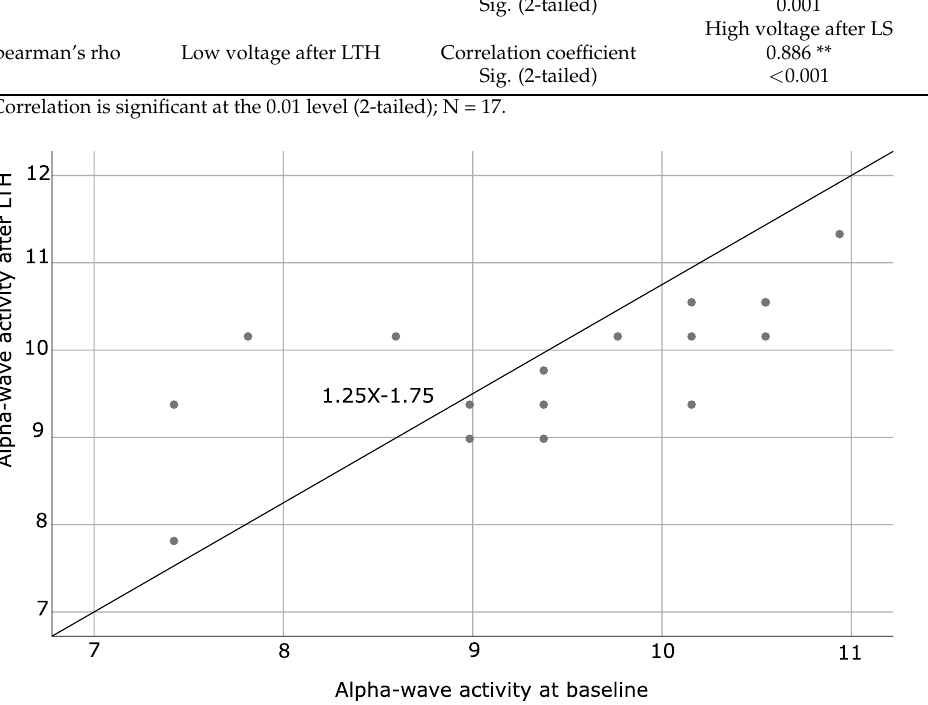
Figure 6. Illustrates the correlation between the alpha-wave activity measured at baseline and after LTH of SA